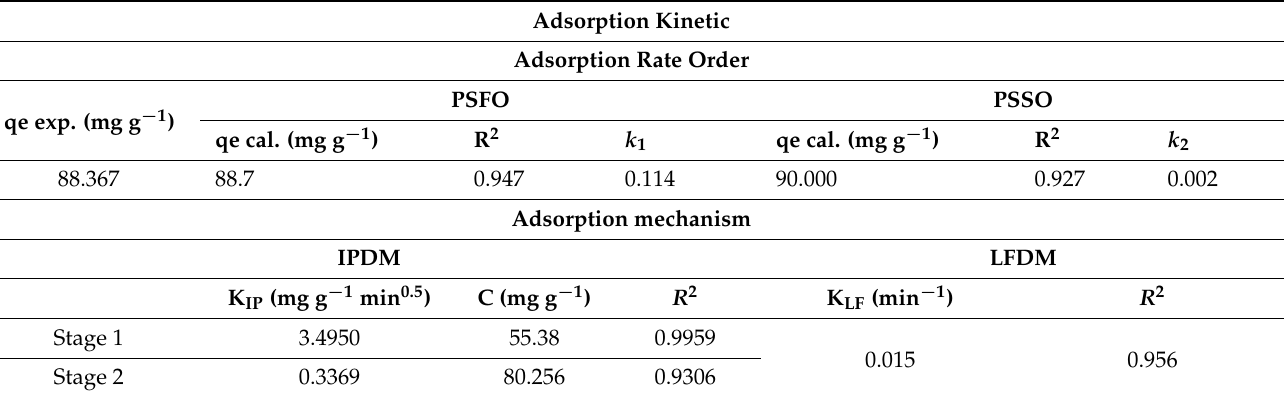
Table 1. The kinetic parameters for Rh-B adsorption on the V@TiO 2 nanocomposite from 50 mg L −1 pollutant solution.